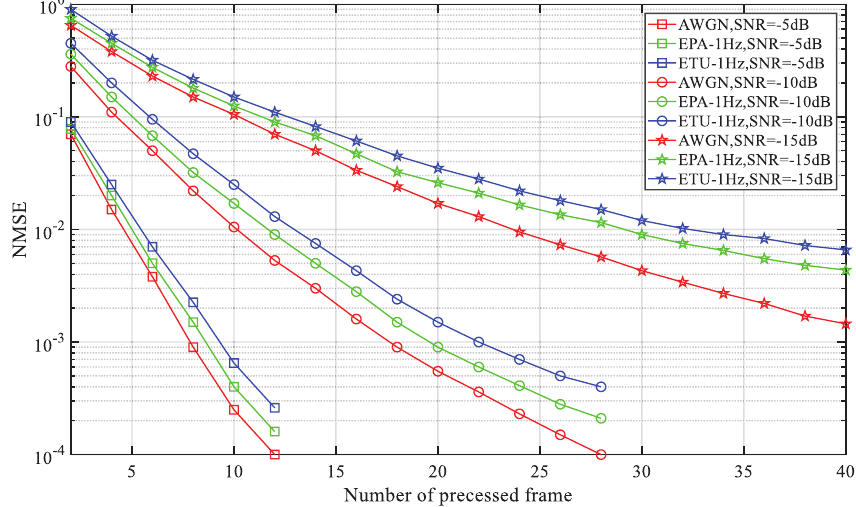
Figure 9. Performance of the FFO pre-estimator with different channel and SNR